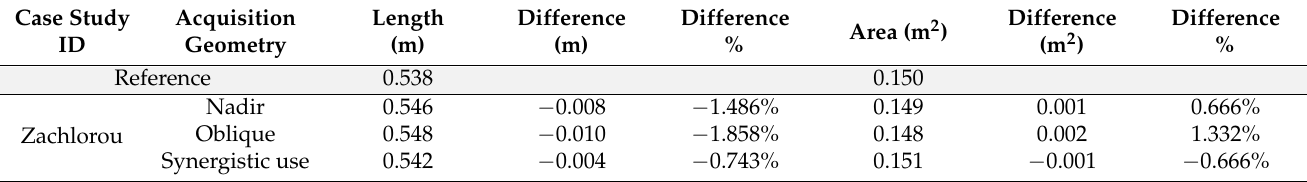
Table 5. Comparison of the dimensions of the aluminum target between the different acquisition ge-